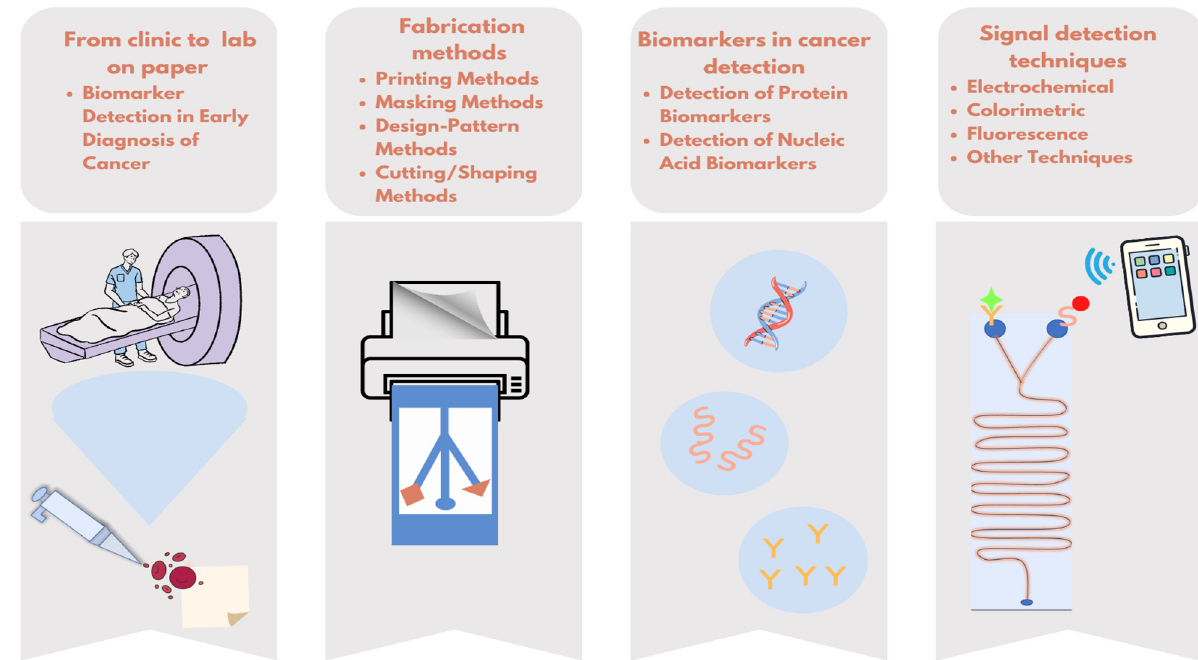
Figure 1. Overview of simplifying cancer diagnostics with paper-based micro fl uidic tests.